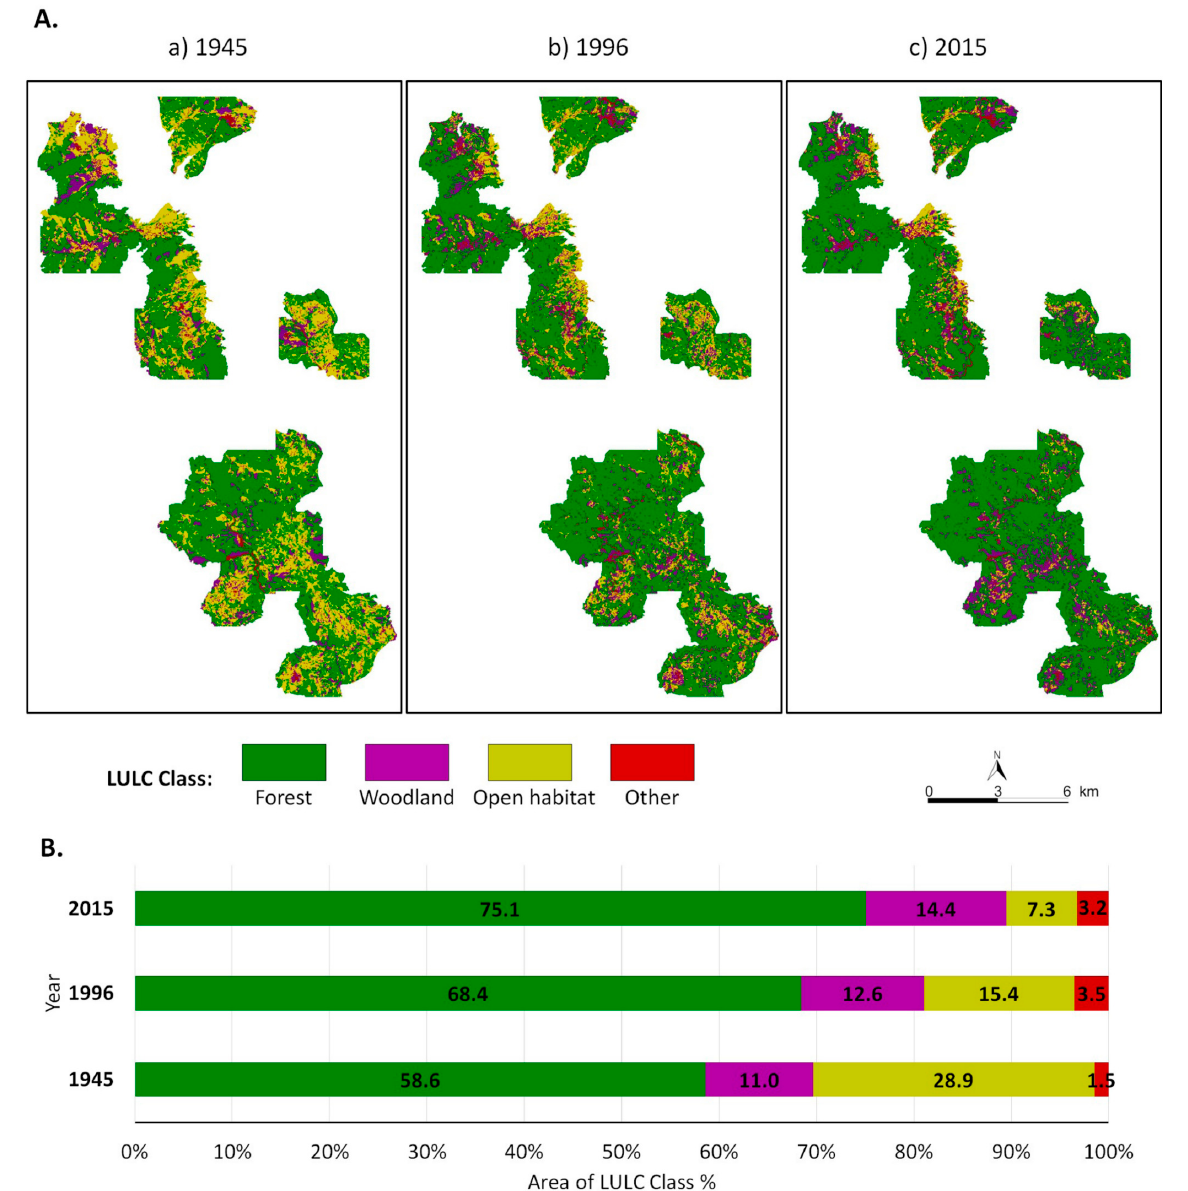
Figure 2. Land use/land cover (LULC) maps produced for the study area ( A ), where a: LULC map for the year 1945, b: for the year 1996 and c: for the year 2015, and ( B ) the percentage of each land cover class for each studied